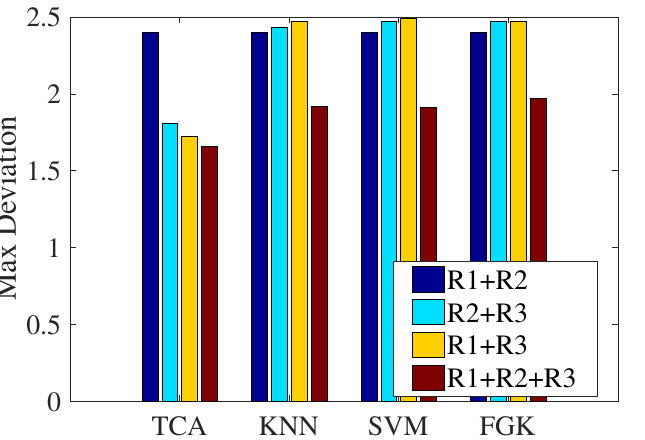
Figure 14. Impact of the combination of multi-domain representations on localization